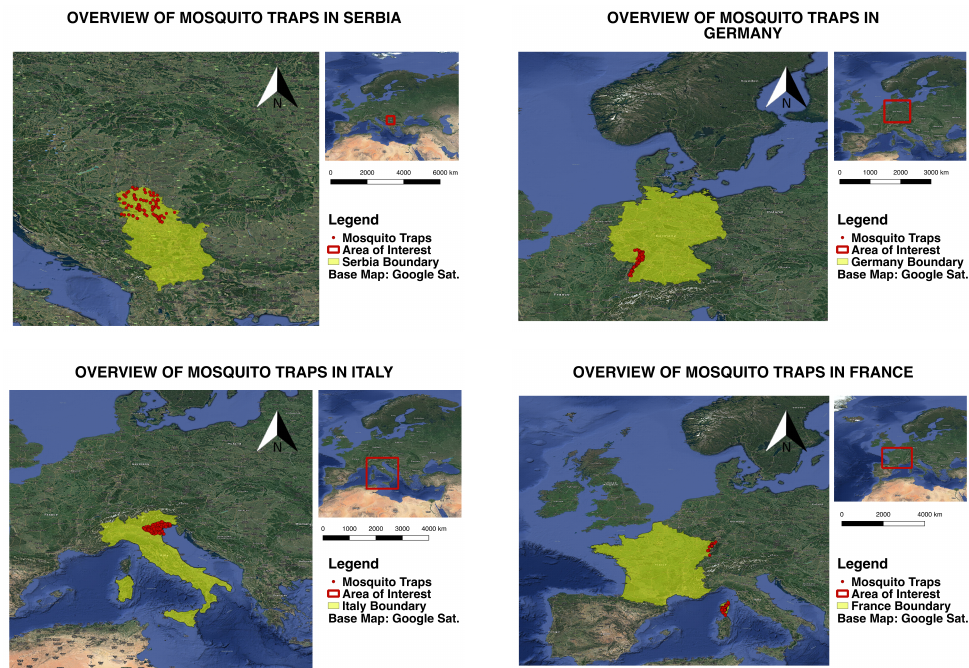
Figure 10. The entomological networks of all cases. ( Top left ): Vojvodina province, Northern Serbia ( Top left : 18.84, 41.85; Bottom right: 23.00, 46.81 Datum WGS84). ( Top right ): Baden Wuerttemberg, Germany ( Top left : 7.58, 48.06; Bottom right: 8.67, 50.03 Datum WGS84). ( Bottom left ): Veneto region, Northeast Italy ( Top left : 18.52, 46.09; Bottom right : 21.47, 44.89 Datum WGS84). ( Bottom right ): Grand-Est and Corsica regions, France ( Top left : 10.64, 44.90; Bottom right : 13.02, 45.99 Datum